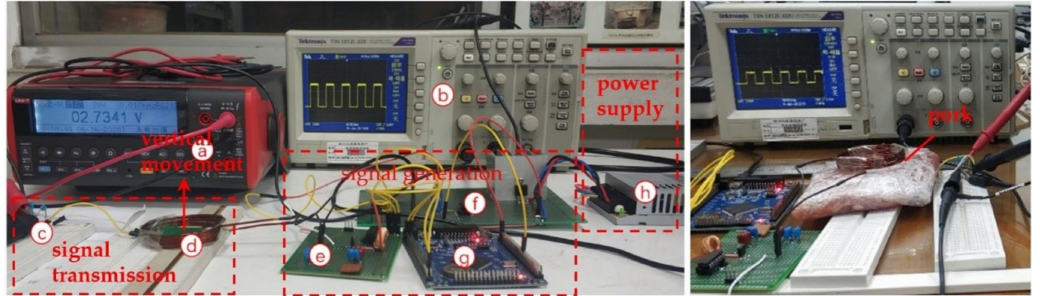
Figure 9. The experiments of output performance test with different media: air ( left ) and pork ( right ). The testing instruments used are multimeter (UNI-T UT805A, a), oscilloscope (Tektronix TDS 1012C- EDU, b). In the picture, the c is the simulated load impedance; the d represents for the T X coil and the R X coil and they move vertically in a coaxial way; the e is the Class E PA circuit; the f is LM317 controllable constant-voltage circuit; the g is STM32 microcontroller; and the h is switching power supply to make the LM317